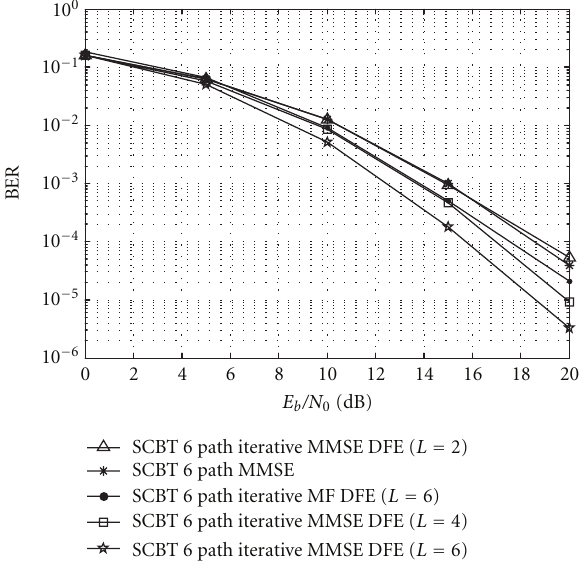
Figure 10: BER performance of iterative MMSE/MF-based